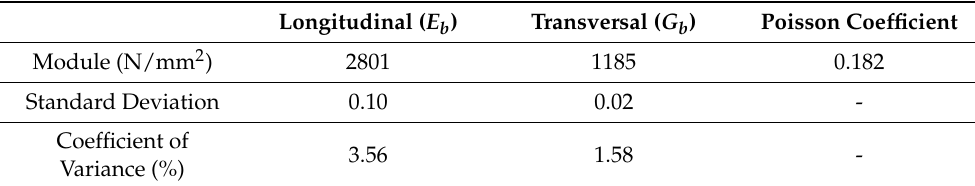
Figure 8. Strain curves-PBB. Table 4. Deformability modules of the blocks–gross Table 4. Deformability modules of the blocks – gross area.